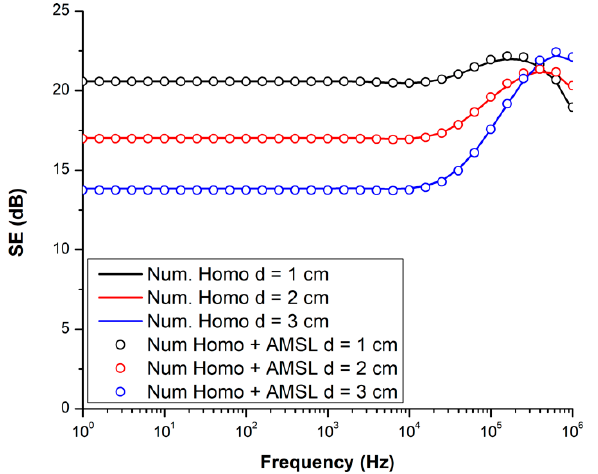
Figure 9. Shielding effectiveness of the homogenized layer (line) and the artificial layer (dot) obtained numerically in near ‐ field for different distances d for a sample radius of 10.5 cm.